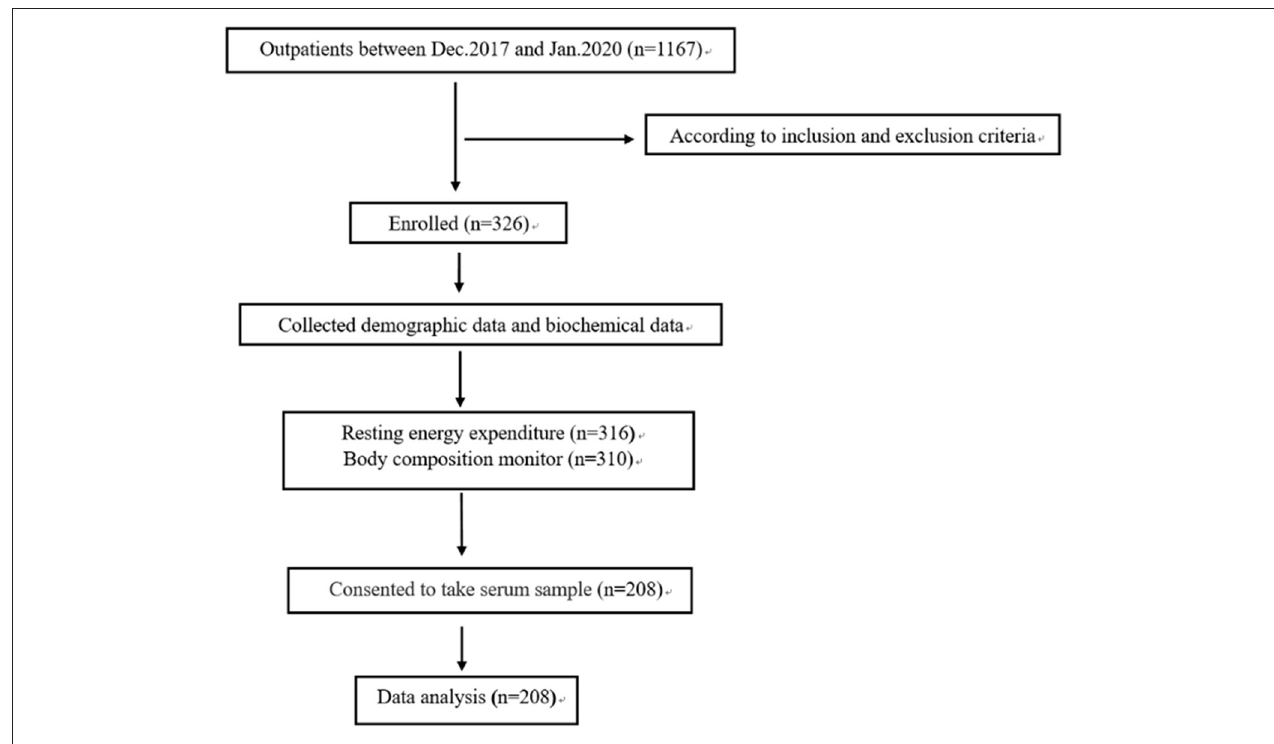
FIGURE 1 | Flow chart of the